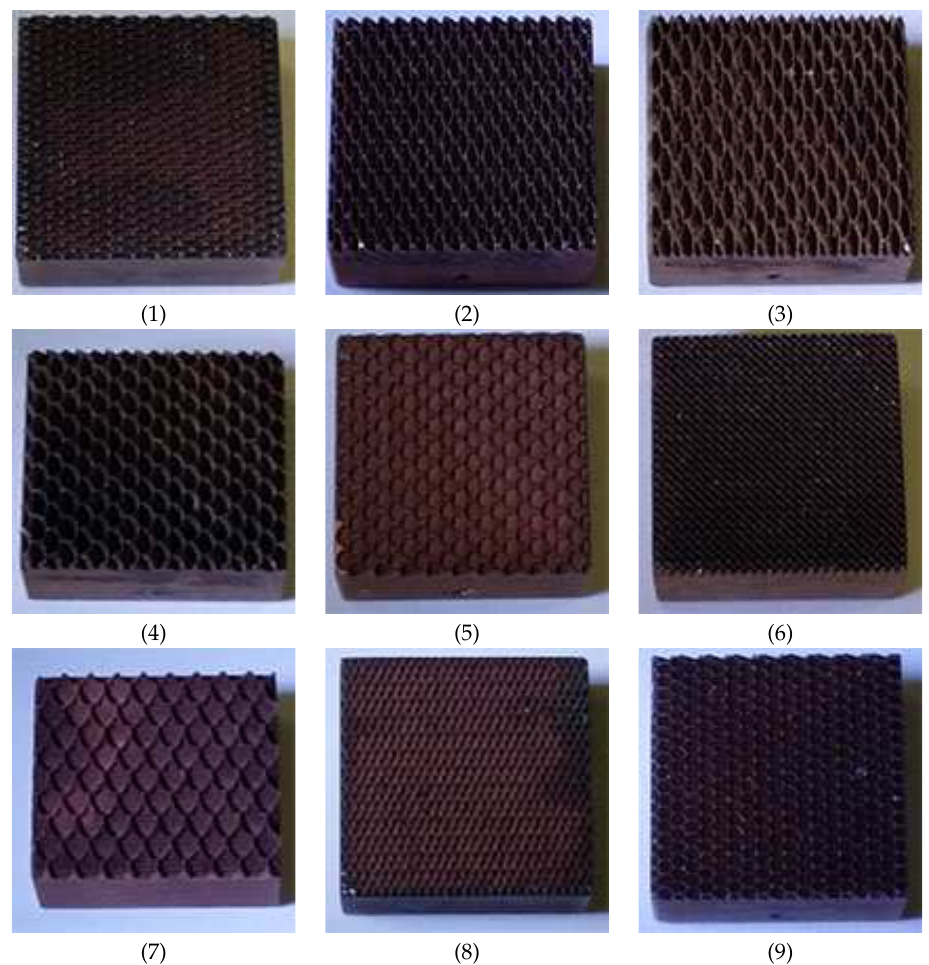
Figure 2. Pictures of the nine ESR patterned samples manufactured by laser etching